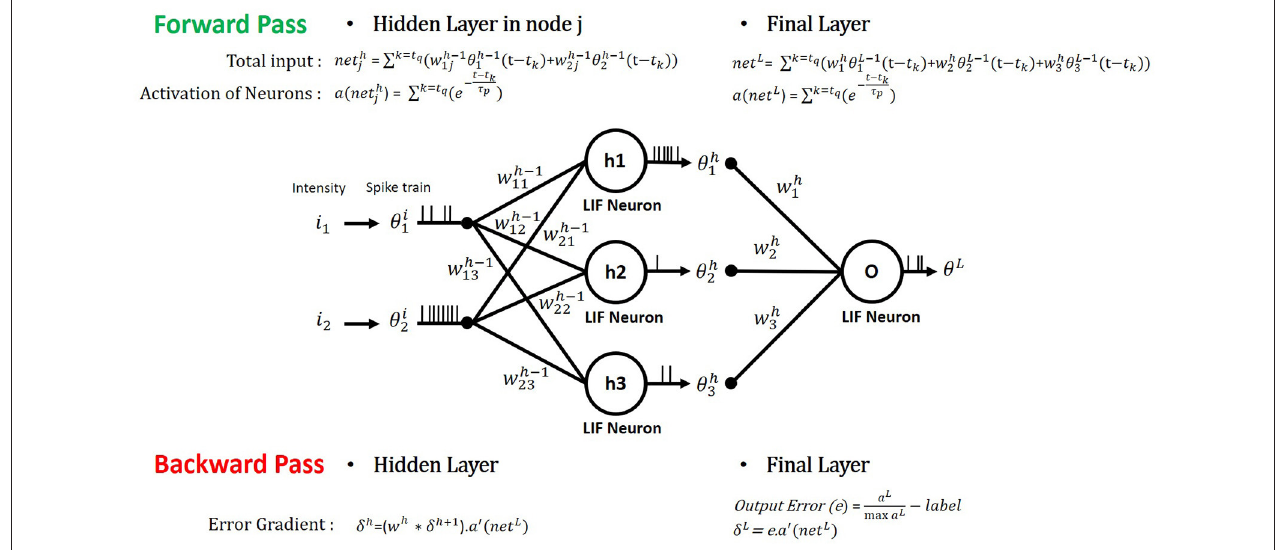
FIGURE 3 | Illustration of spike forward and backward propagation of a multi-layer SNN consisting of LIF neurons. In forward pass, the spiking neuron integrates the input current (net) generated by the weighted sum of the pre-neuronal spikes with the interconnecting synaptic weights and produces an output spike train. In backward pass, the derivatives of designated loss function with respect to each synaptic weight are calculated from